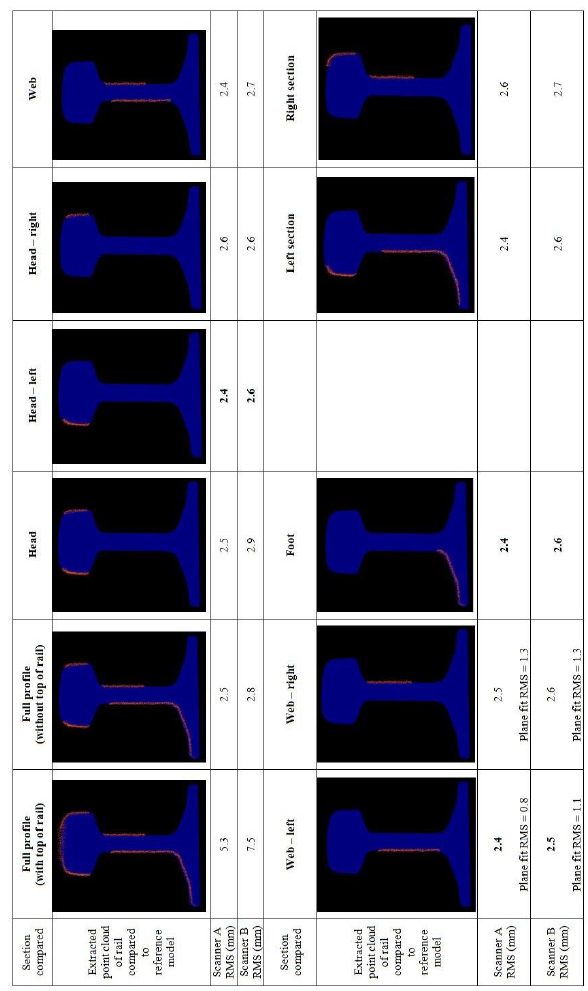
Table 1 - Summary of RMS values of fitting point cloud to modelled track